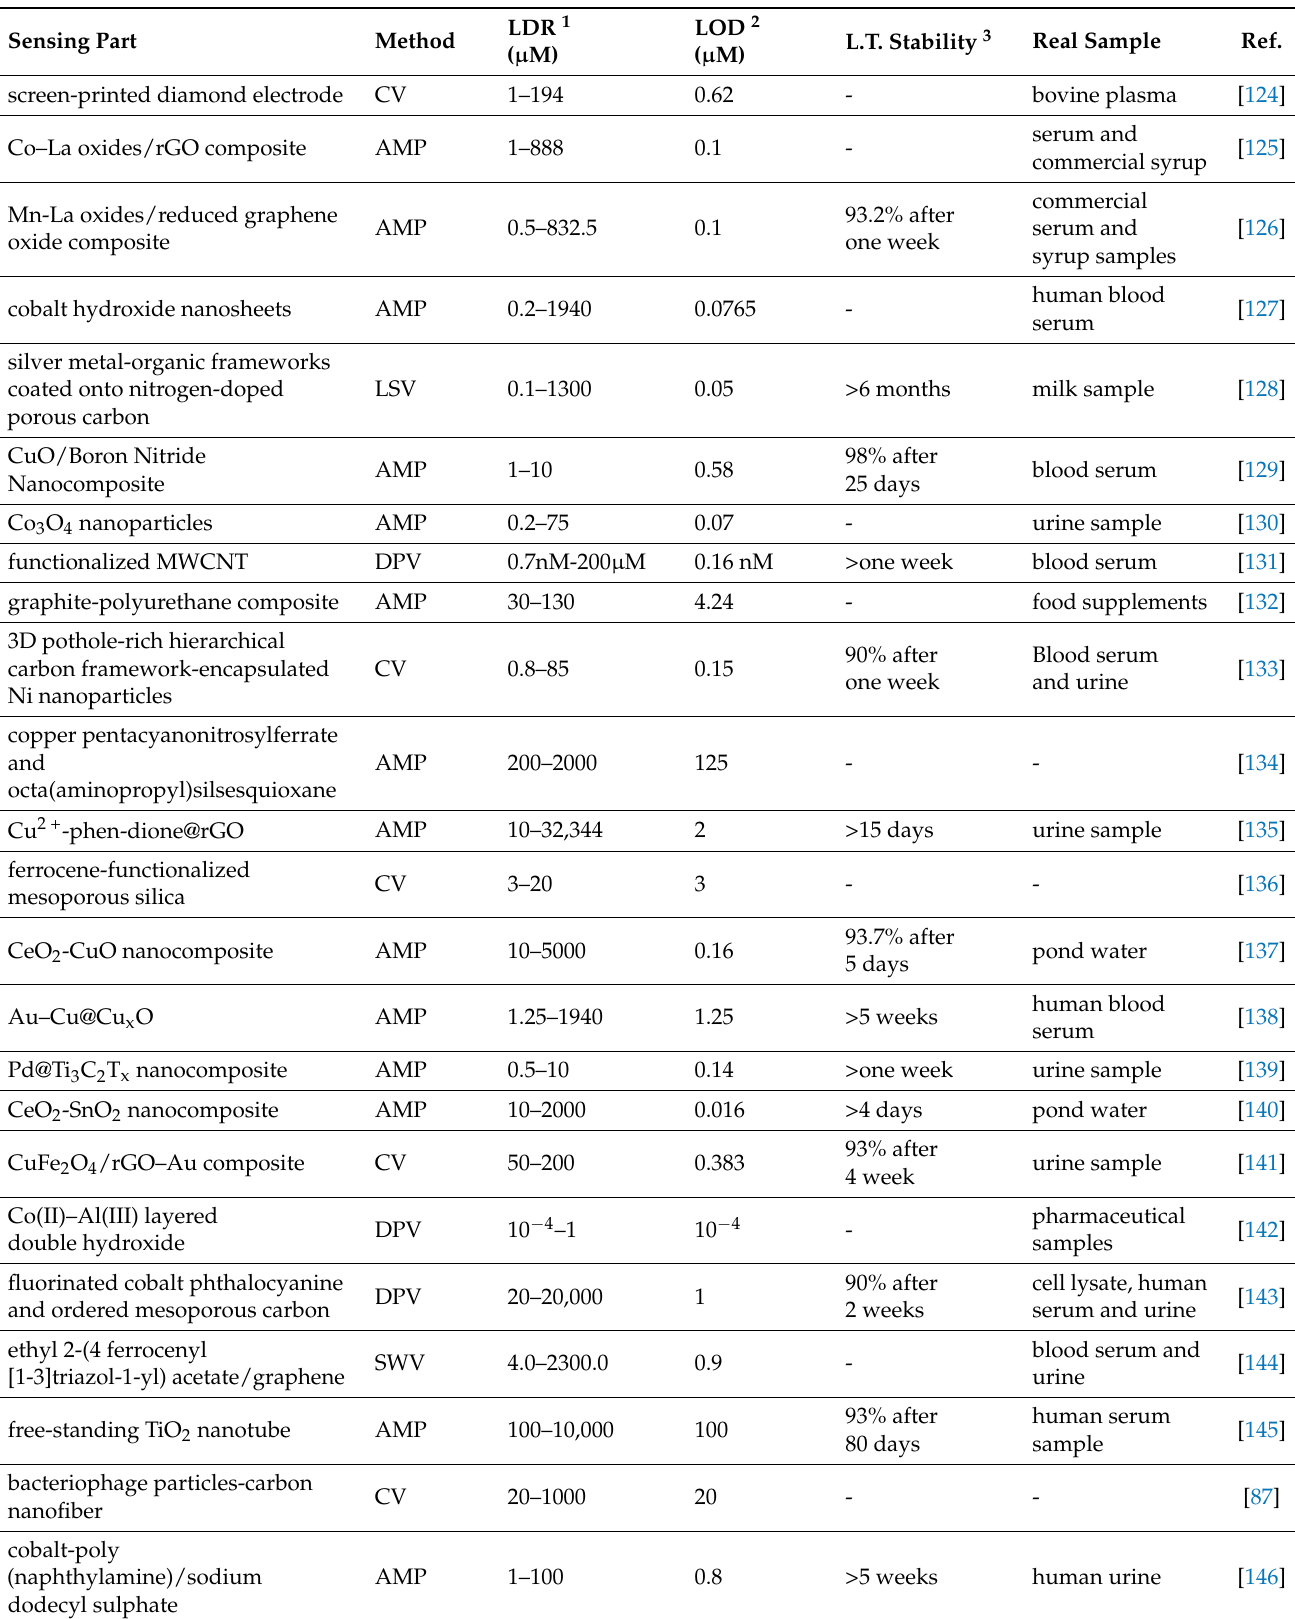
Table 2. Proposed electrochemical cysteine sensors, since 2010, along with the most important respective figures of